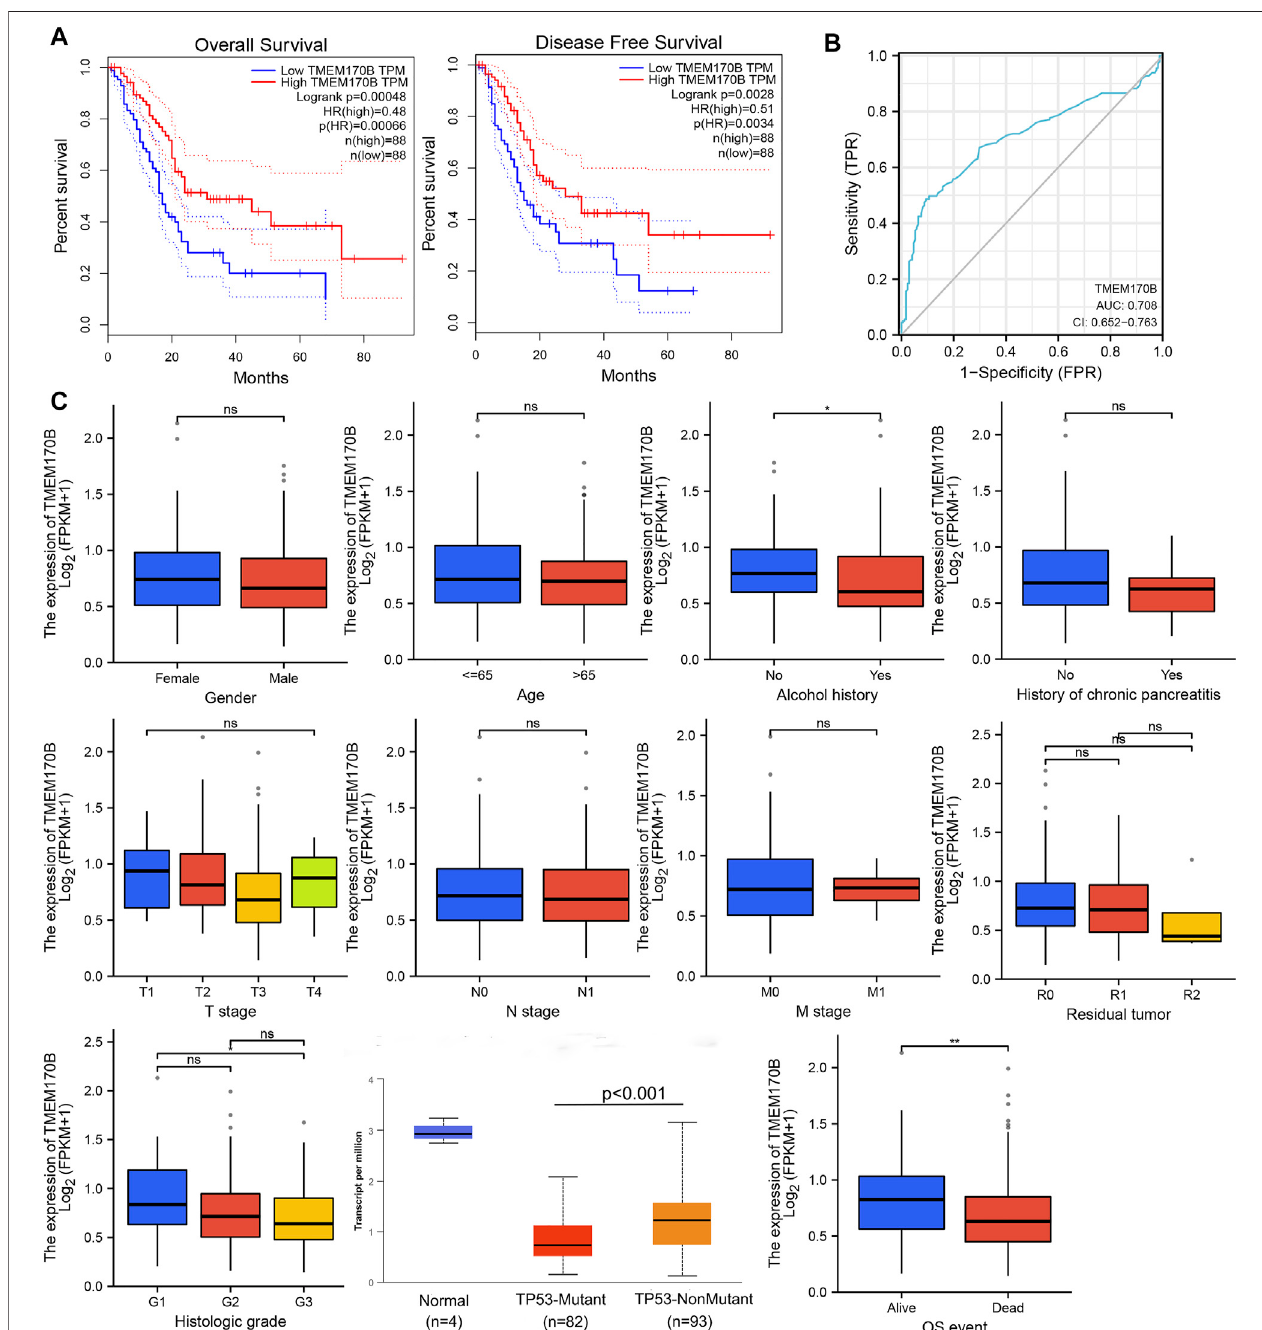
FIGURE3| Signi fi canceofTMEM170B expression andprognosisofpancreatic adenocarcinoma(PAAD)intheTCGAcohort. (A) TheKaplan – Meiersurvivalcurve analysis showed that low TMEM170B expression was related to poor overall survival and relapse-free survival. (B) Receiver operator characteristic curve analysis of TMEM170B expression in PAAD. (C) Relationship between TMEM170B expression and clinicopathological factors. ns: not signi fi cant; * p < 0.05; ** p < 0.01.